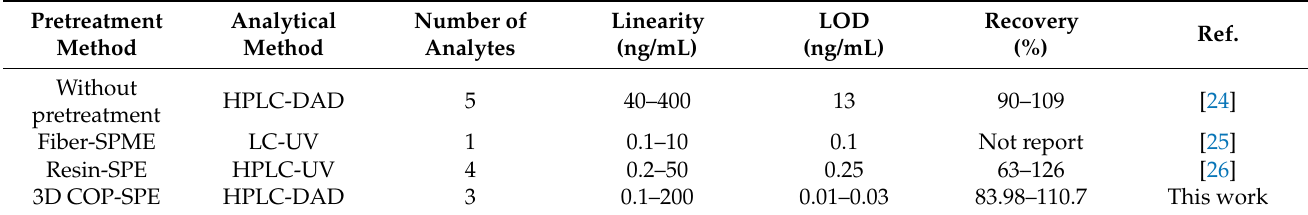
Table 3. Method comparison for the analysis of amphenicol drugs in water